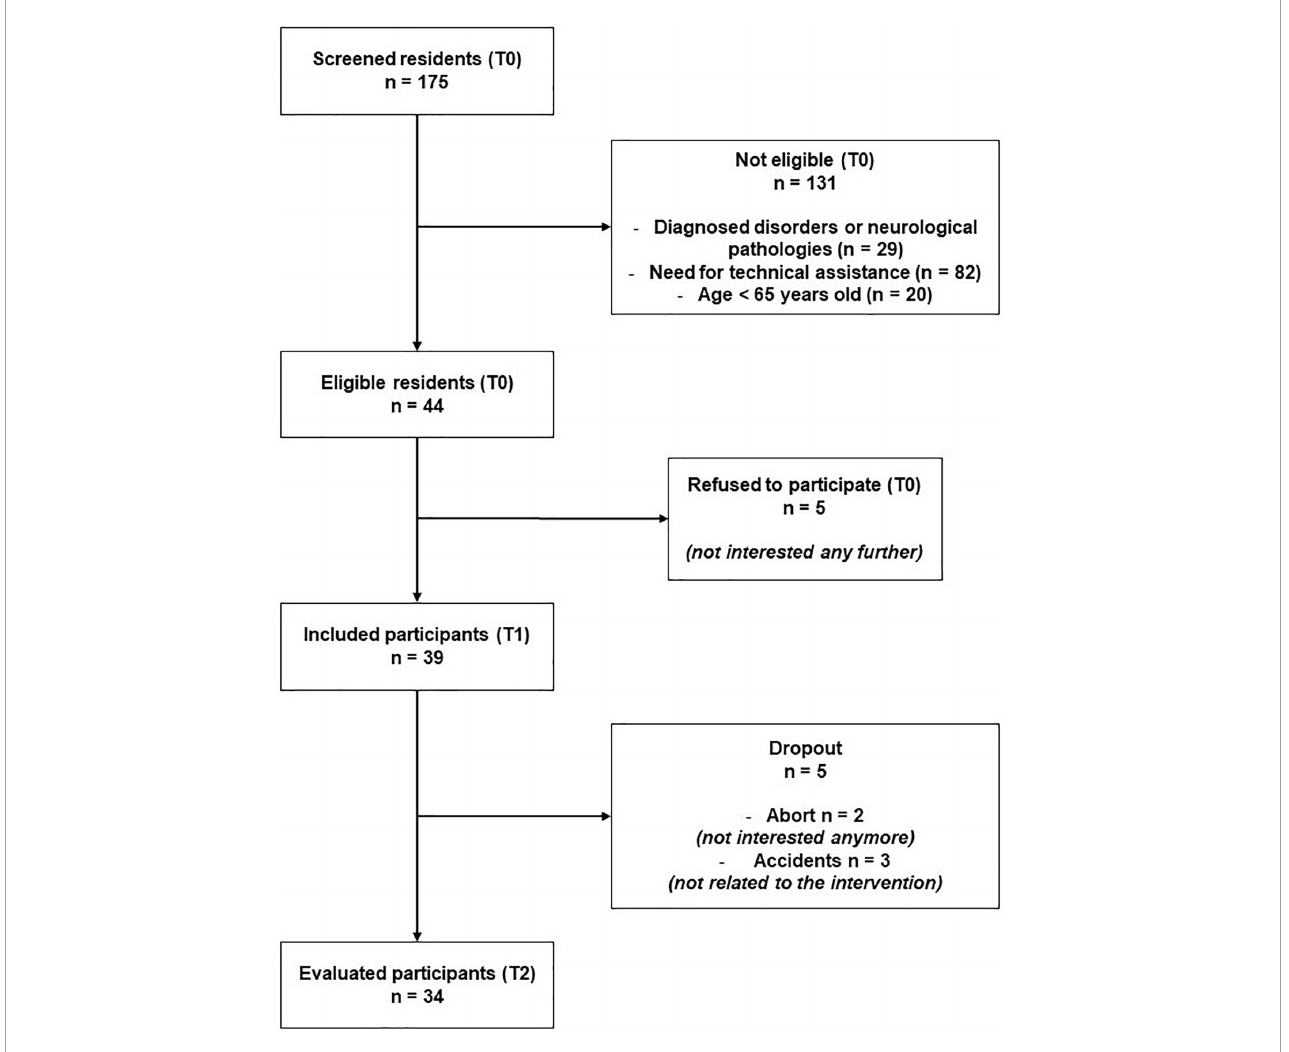
FIGURE2 Flowchart of the